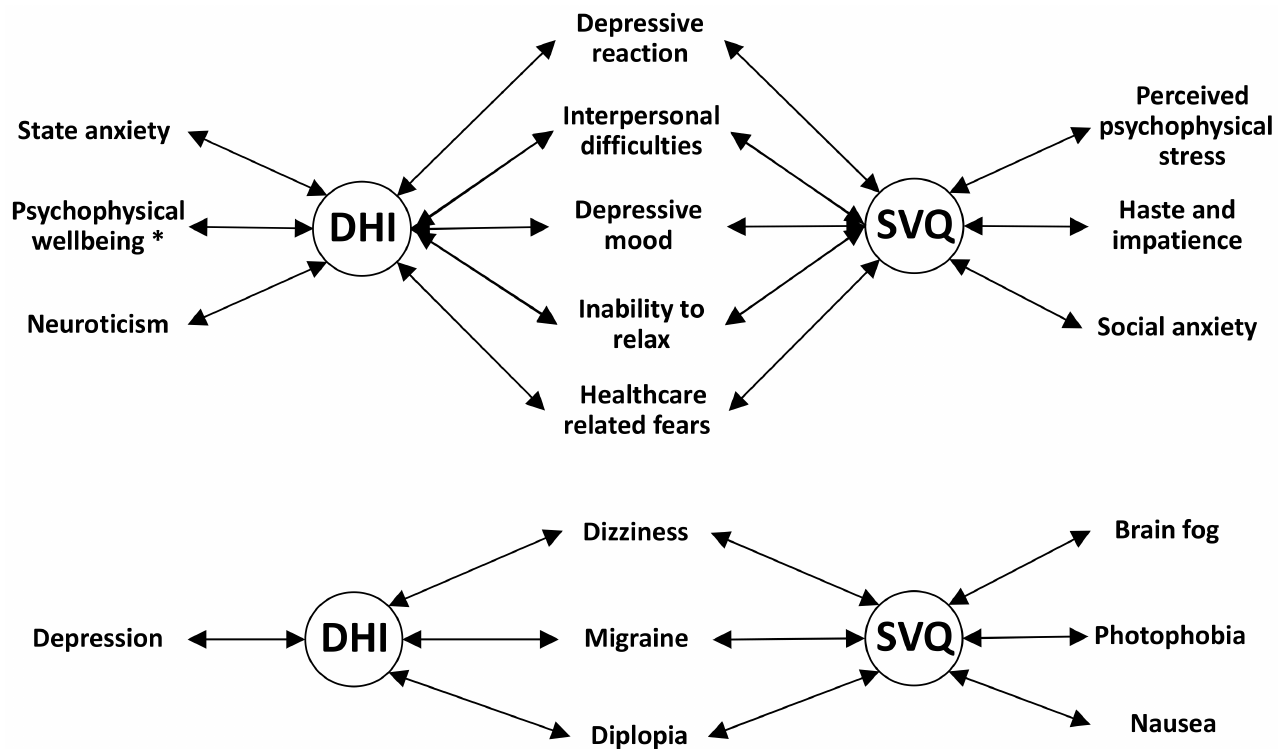
Figure 2. Significant associations between Dizziness Handicap Inventory (DHI) or Situational Vertigo Questionnaire (SVQ) scores and the indicated CBA-H items (above) or non-pain symptoms (below). DHI: significant associations are highlighted by the analysis of contingency tables of the DHI handicap levels cross-classified by the CBA-H cutoffs, or cross-classified by the presence/absence of symptoms ( p < 0.01, chi-squared test). SVQ: significant associations are indicated by the SVQ scores cross- classified by the CBA-H cutoffs, or cross-classified by the presence/absence of symptoms ( p < 0.01, Wilcoxon rank sum test). In all cases, higher DHI or SVQ scores correspond to presence of condition or symptoms, except Psychophysical wellbeing (*) for which higher DHI scores correspond to lack of